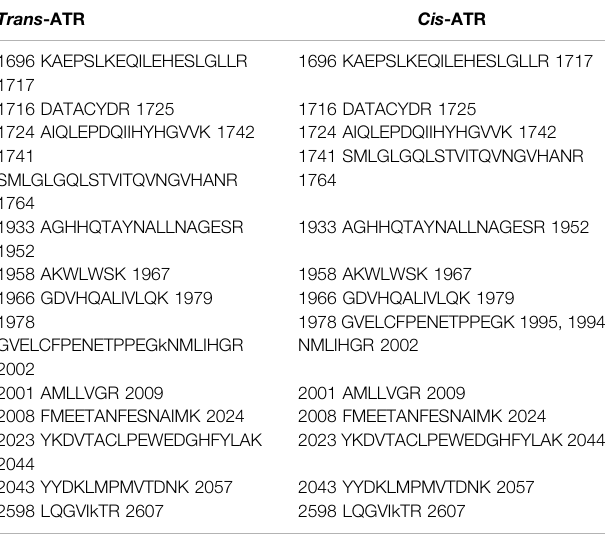
TABLE 2 | Identi fi ed peptides involve in ATR dimerization for ATR WT and mutant P429A and S428A